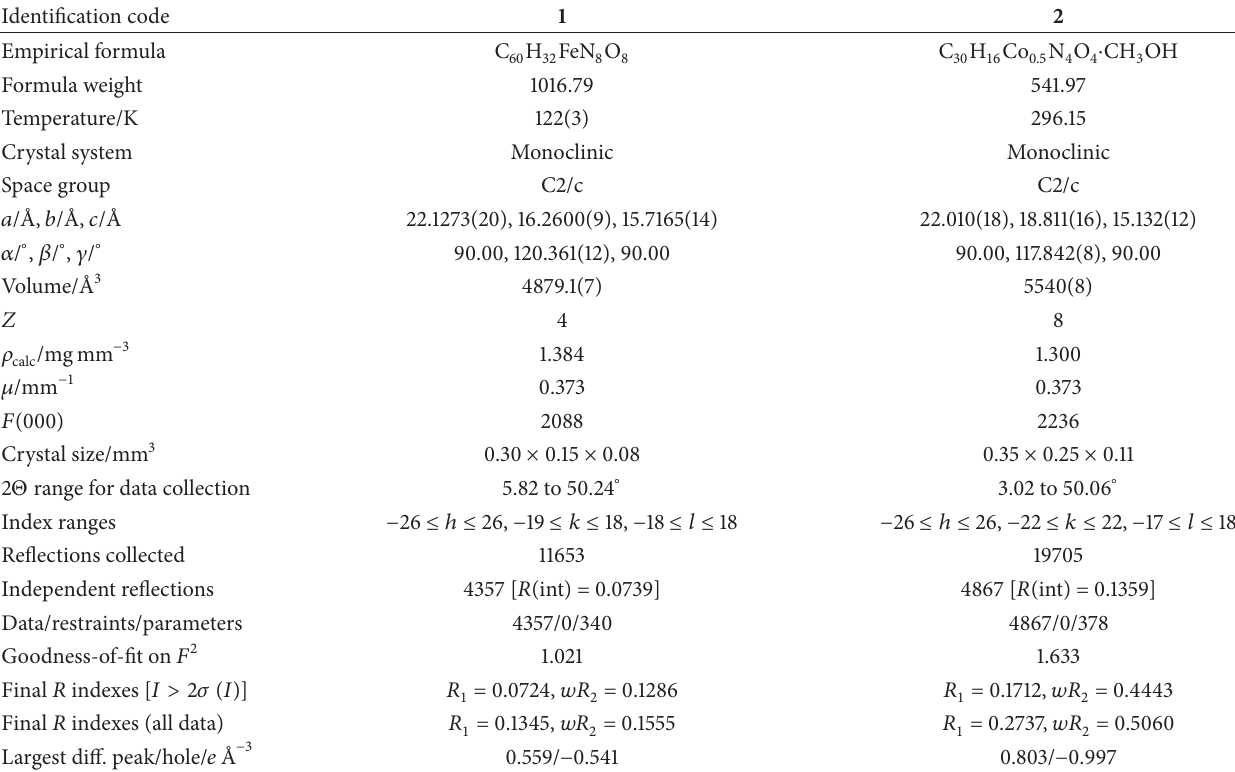
Table 1: The X-ray crystal data collection for complexes 1 and 2